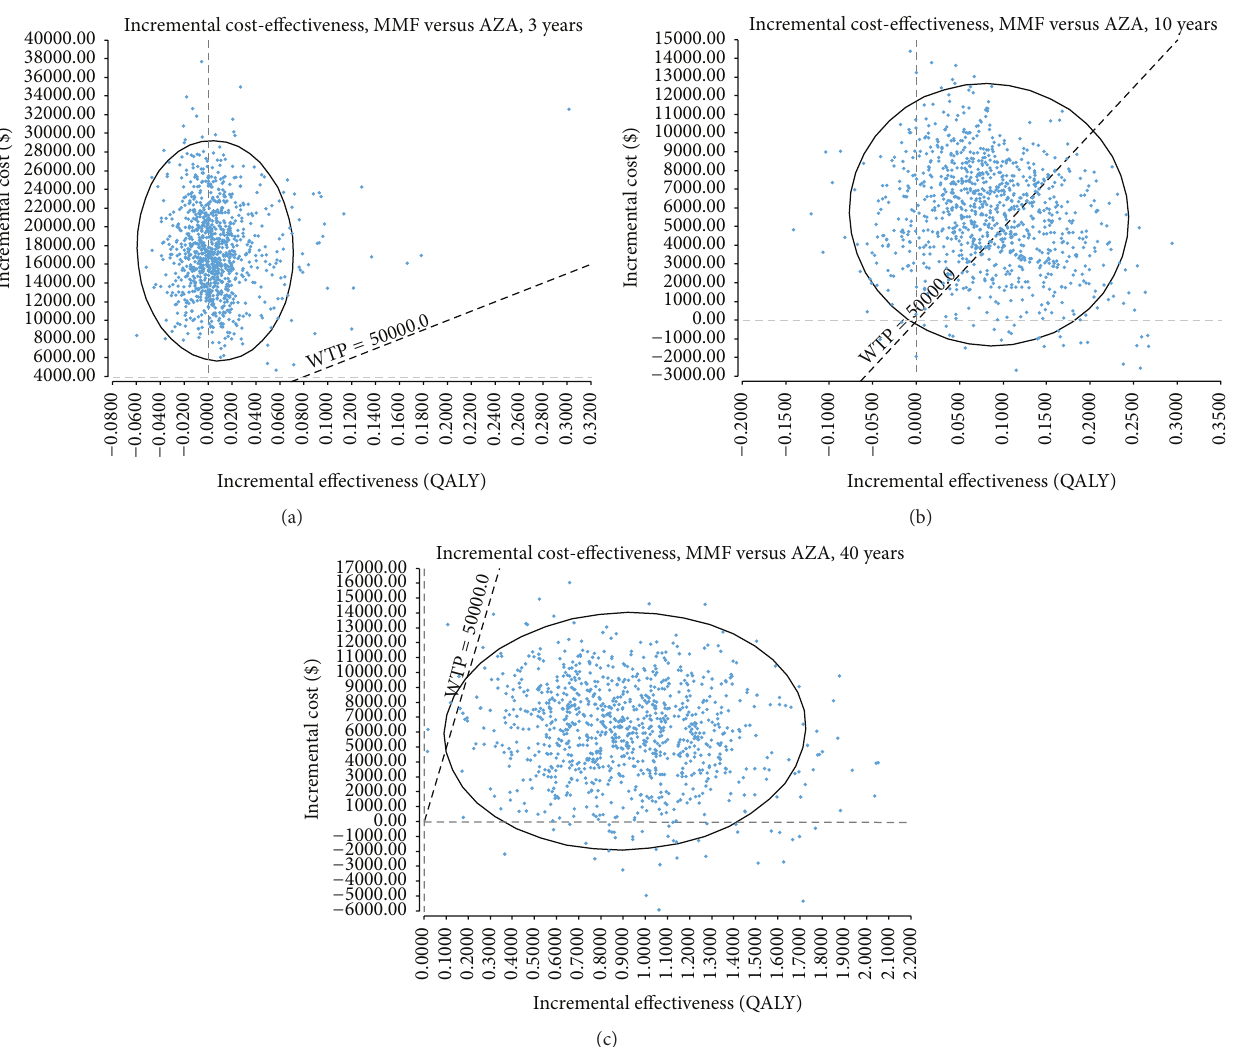
Figure 3: Incremental cost-effectiveness scatter plots of the base-case model. (a) 3 years; (b) 10 years after completing 3-year maintenance therapy; (c) 40 years after completing 3-year maintenance therapy. Each single point represents pairs of incremental cost and effectiveness values from probabilistic sensitivity analyses via second-order Monte Carlo simulation of 1,000 iterations. The ellipsis represents the 95% confidence interval. The dotted diagonal line represents the WTP threshold of $50,000/QALY. AZA: azathioprine; MMF: